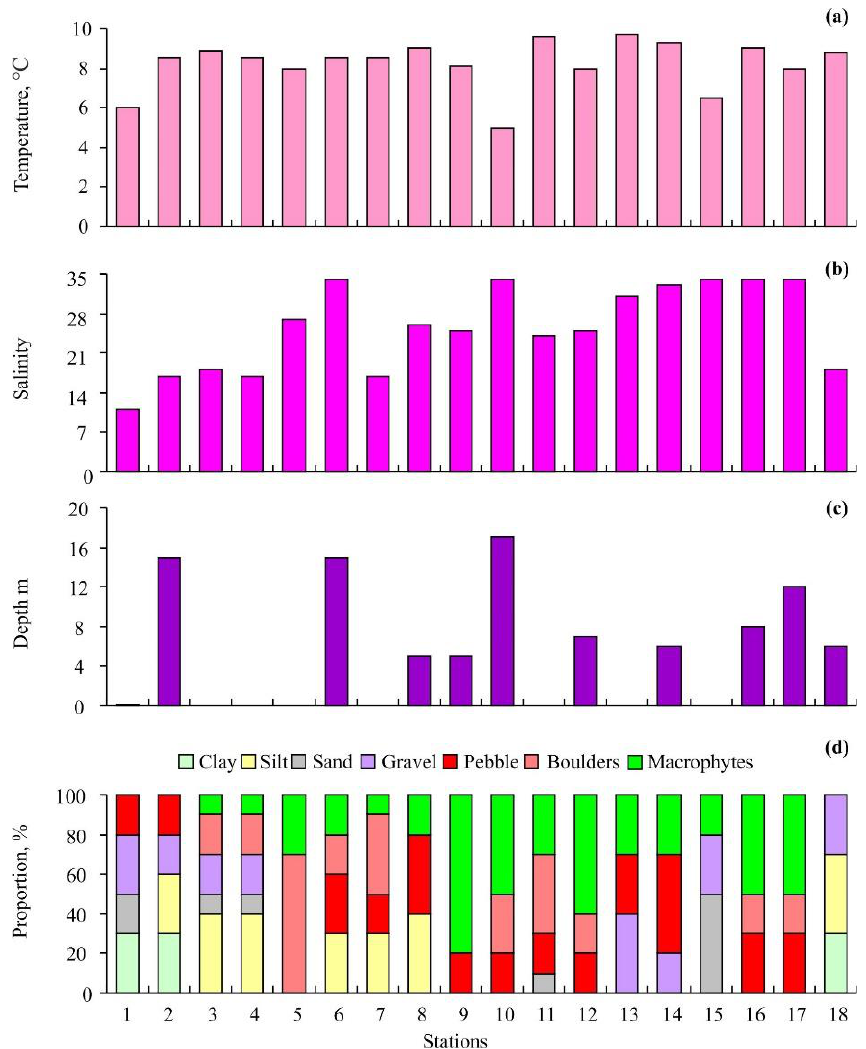
Figure 2. Environmental conditions at sampling stations in Grønfjorden: ( a ) — temperature, ( b ) — salinity, ( c ) — depth, ( d ) — substrates.